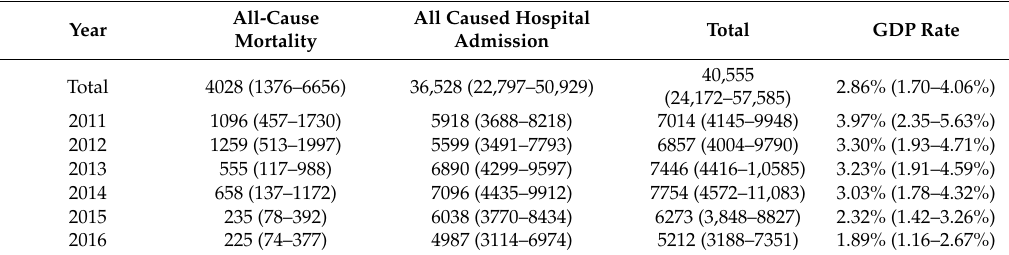
Table 3. Estimated economic loss by ambient pollutant in Guangxi (millions of USD).